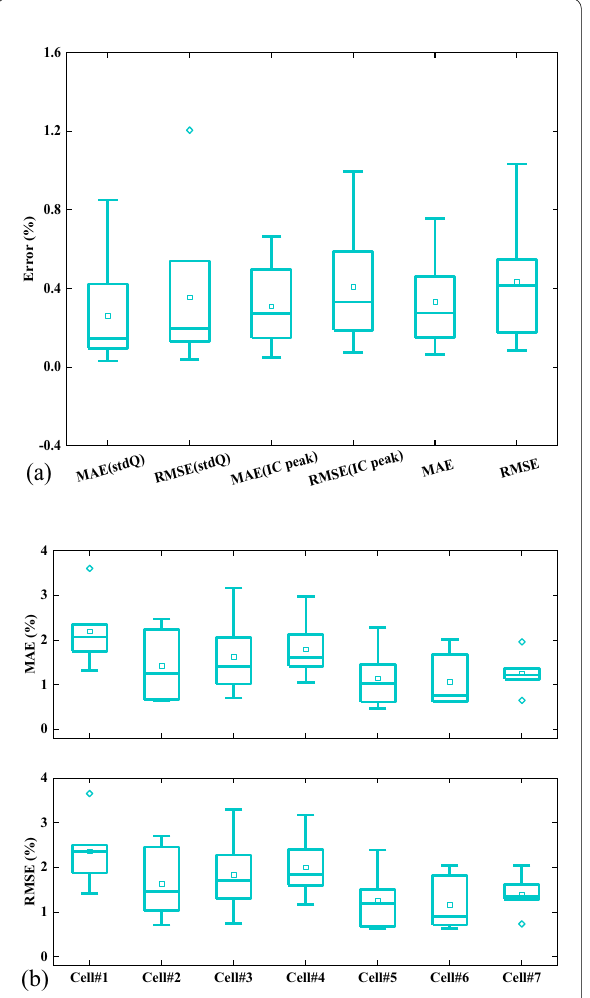
Figure 7 a Statistical errors, b Statistical errors for the capacity estimation results using the data trained by a cell to estimate capacities of other cells